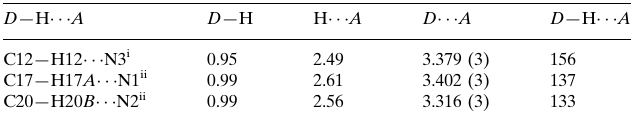
Hydrogen-bond geometry (A˚ , (cid:4) ).